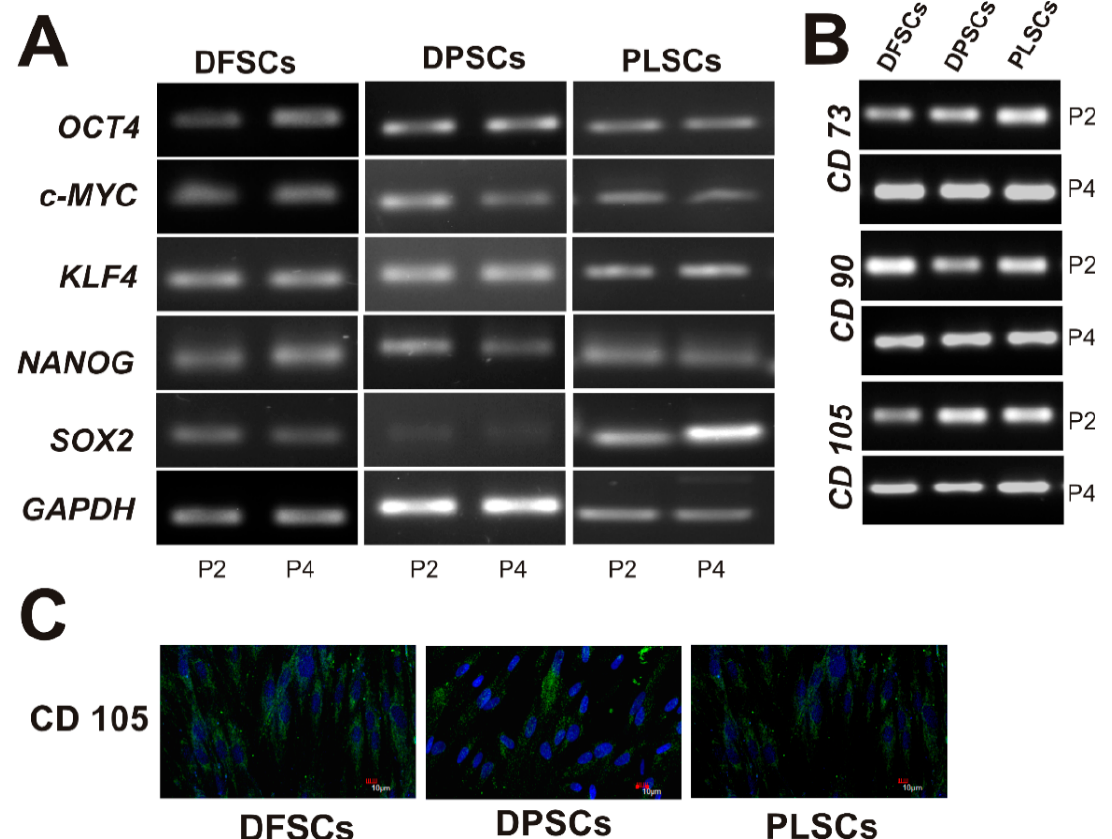
Figure 3. Gene expression profile and immunoflourescence of CD105 of dental stem cells. ( A ) The gene expression profile of embryonic-related genes at passages 2 and 4 (P2, P4) of dental follicle stem cells (DFSCs), dental pulp stem cells (DPSCs), and periodontal ligament stem cells (PLSCs). ( B ) Representative expression profile of mesenchymal stem cell markers ( CD73 , CD90 , and CD105 ) in DFSCs, DPSCs, and PLSCs at P2 and P4. ( C ) Immunophenotype analysis in DFSCs, DPSCs, and PLSCs by confocal microscopy shows the presence of CD105, a positive mesenchymal marker. Housekeeping gene GAPDH was used as an internal